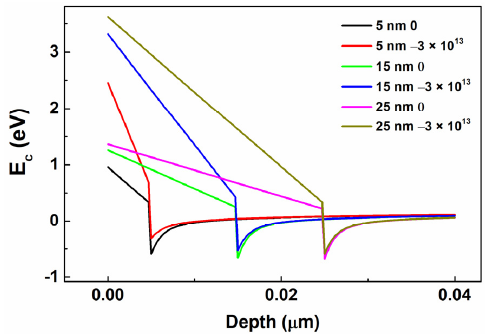
Figure 7. The conduction band diagram of HEMT for different InAlN barrier layer thicknesses with and without additional surface charge density.